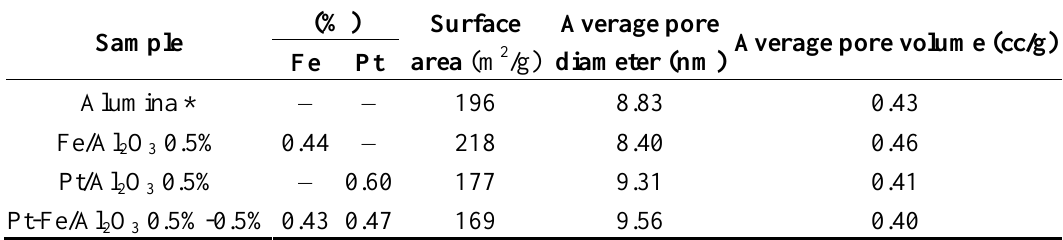
Table 1. Textural properties and weight percent of metals in the catalysts.